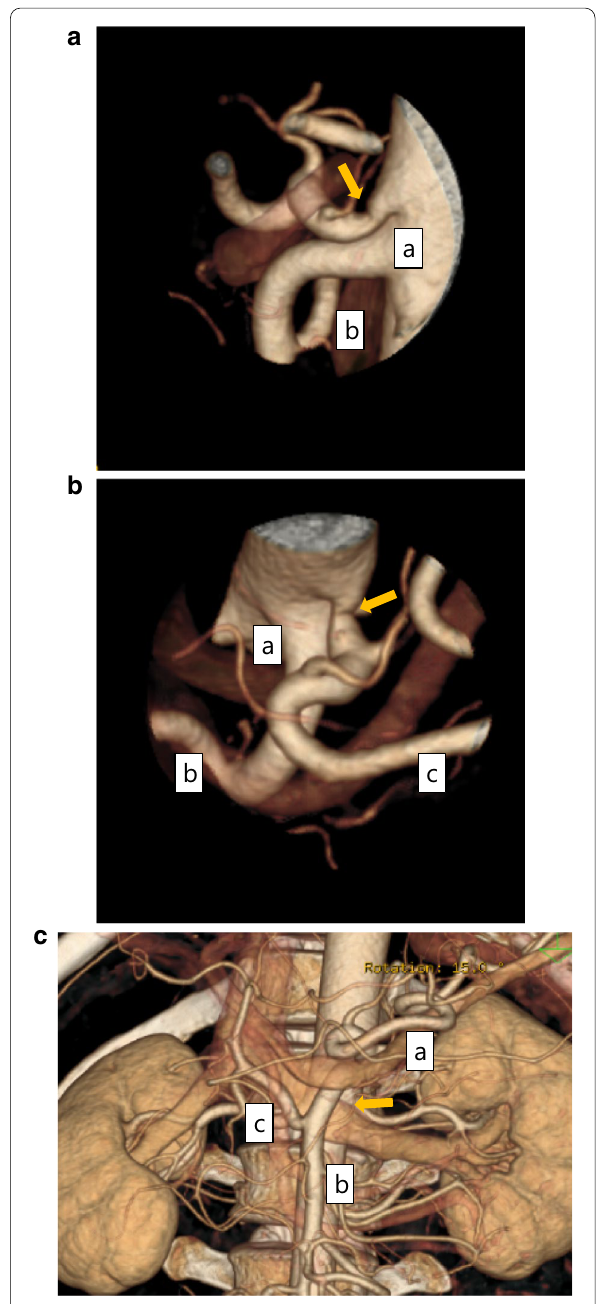
Fig. 1 Preoperative abdominal computed tomography scan. a , b The origin of the celiac artery was stenosed due to compression of the median arcuate ligament (MAL): a superior mesenteric artery, b common hepatic artery, c splenic artery. c Adachi V vascular anomaly was detected: a splenic artery, b superior mesenteric artery, c common hepatic